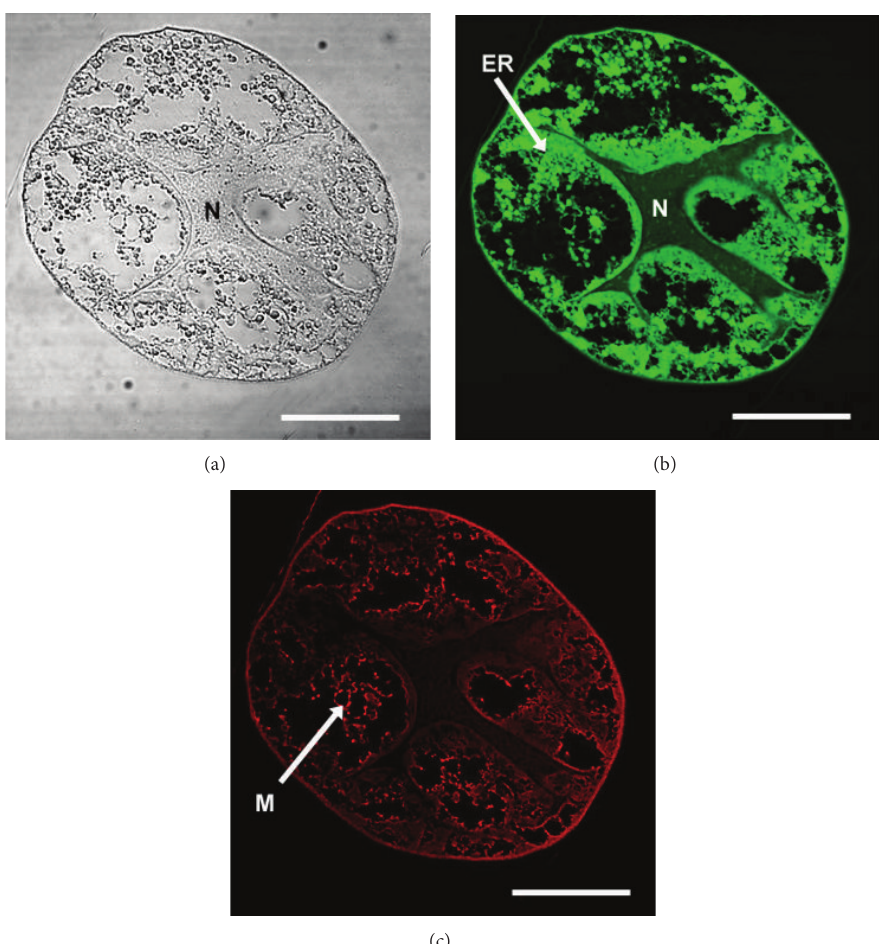
Figure 5: Semithin sections of teratocytes were dual-stained with Mitotracker for mitochondria and with DiOC 6 for endoplasmic reticulum. (a) Transmitted light micrograph of teratocyte showing internal structure of the cell. (b) Same cell section stained with DiOC 6 showing green staining of ER surrounding the dark unstained bodies. (c) Same section stained with Mitotracker (red) showing distribution of mitochondria within the teratocyte. ER: endoplasmic reticulum, M: mitochondria, N: nucleus. Scale bars = 20 𝜇 m.